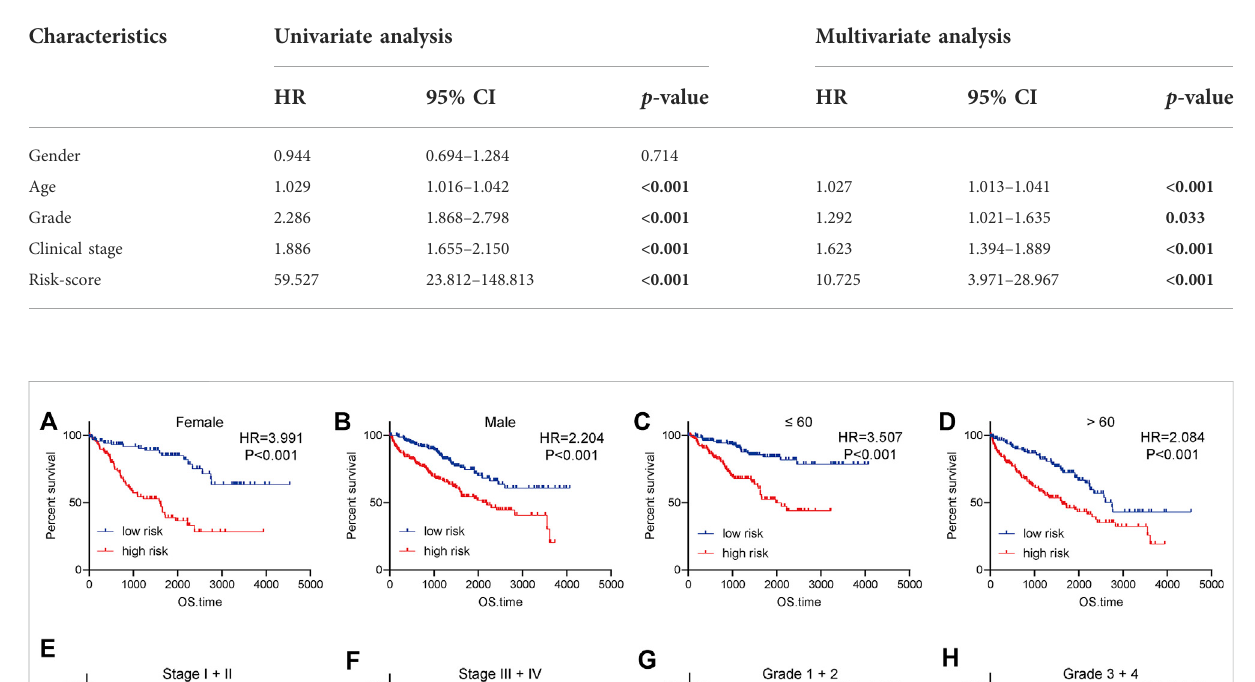
TABLE 1 Univariate and multivariate analysis of survival factors in patients with ccRCC.